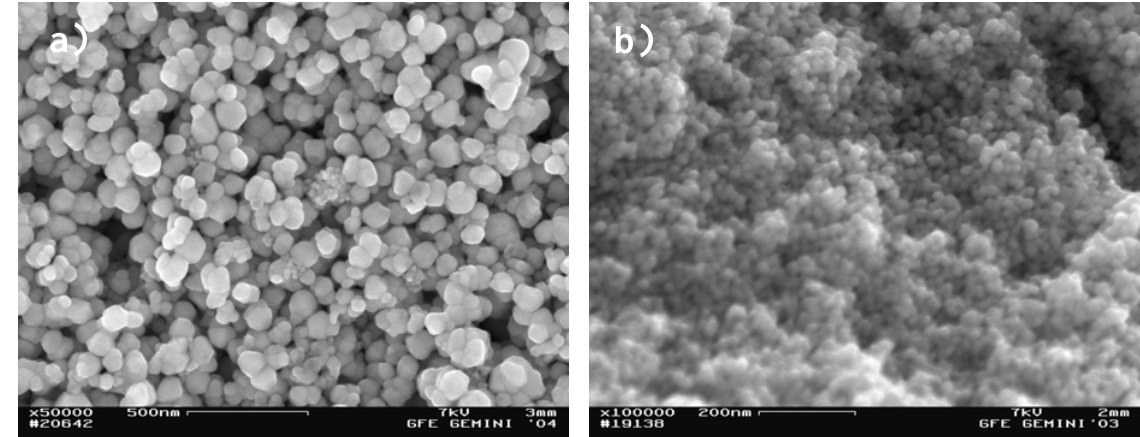
Figure 2. SEM-pictures of a) zinc oxide nanoparticles ( ∅ = 89 nm ± 19 nm) and b) indium oxide nanoparticles ( ∅ = 19 nm ± 3